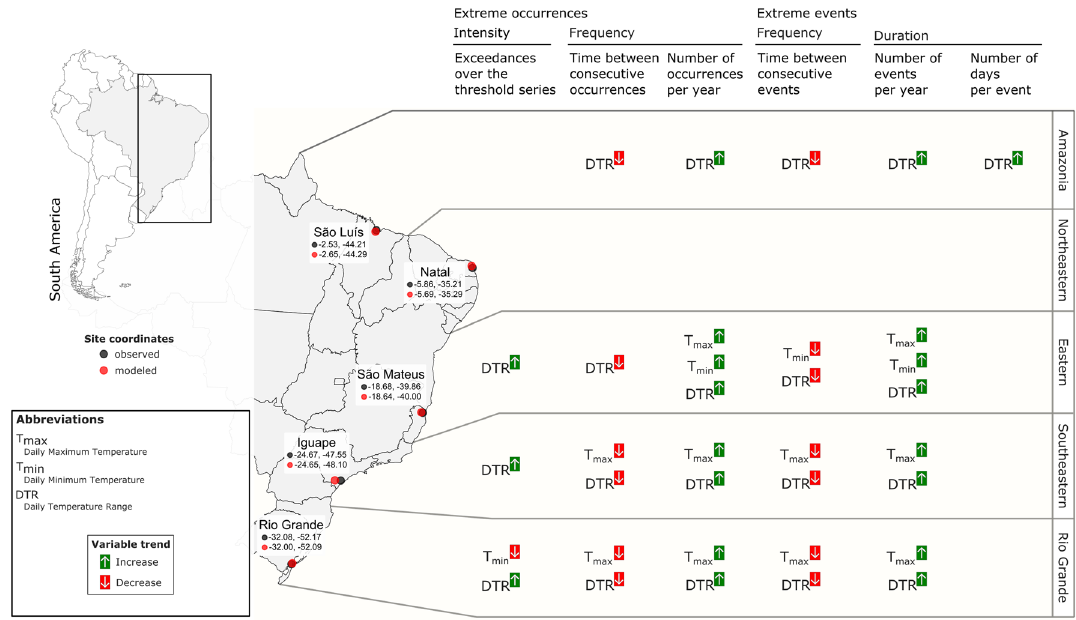
Figure 1. Overall statically significant results from trend analysis to all 5 MEOW in the last 40 years. The results are presented to the following response variables: Daily maximum temperatures (T max ); Daily minimum temperatures (T min ); and Daily temperature range (DTR), with their respective extreme indexes that indicate intensity (Exceedances over the threshold series), frequency (both Time elapsed between consecutive extreme occurrences and events, as well as the Number of extremes per year), and duration (Number of days per extreme